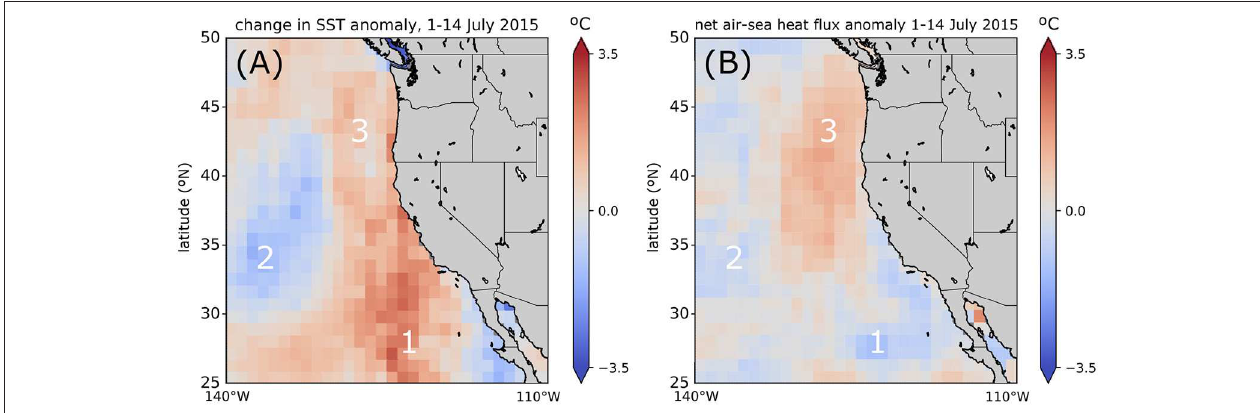
FIGURE 4 | Terms in a time-integrated 1-D heat anomaly budget for the ocean surface mixed layer (section 3.4) during 1–14 July 2015. (A) Change in SST anomaly from 1 July to 14 July at each location, relative to a daily climatology. (B) Accumulated anomaly in the net air-sea heat flux during 1–14 July. Positive indicates anomalous ocean warming (or equivalently, weaker cooling than in the climatology). If the 1-D heat budget closed exactly, the two panels would look the same. For consistency, (A) is based on the SST product distributed with OAFlux, not the CMC SST used elsewhere in this study, but the CMC product gives a very similar result (not shown). To facilitate comparison with (A) , the heat flux anomalies in (B) are converted to the change in SST that would be generated for a climatological mixed 20 m). White numbers mark regions referred to in section layer depth of 20 m, following Flynn et al. (2017) (i.e., each heat flux is scaled by ρ 0 c p h with h = ∼